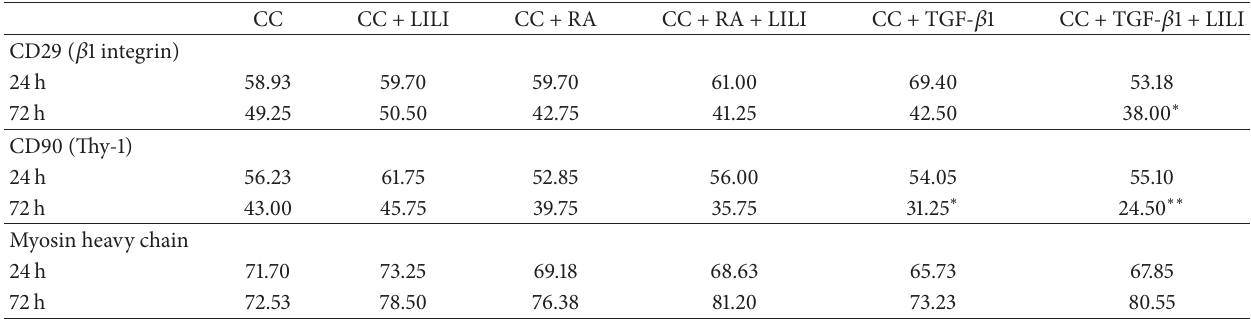
Table 2: Flow cytometric results for the expression of the markers for both ADSCs and SKUT-1 cells. CD29 and Thy-1 expressions decreased significantly at 72 h in cocultures that had TGF- 𝛽 1 and were irradiated at 72 h. ∗ 𝑃 < 0.05 and ∗∗ 𝑃 < 0.01 . CC CC + LILI CC + RA CC + RA + LILI CC + TGF- 𝛽 1 CC + TGF- 𝛽 1 +